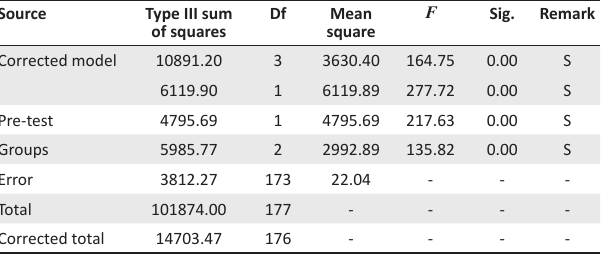
TABLE 2: Summary of analysis of variance analysis of fraction achievement test for post-test mean scores of Ben, Will and Greg teaching groups. Source